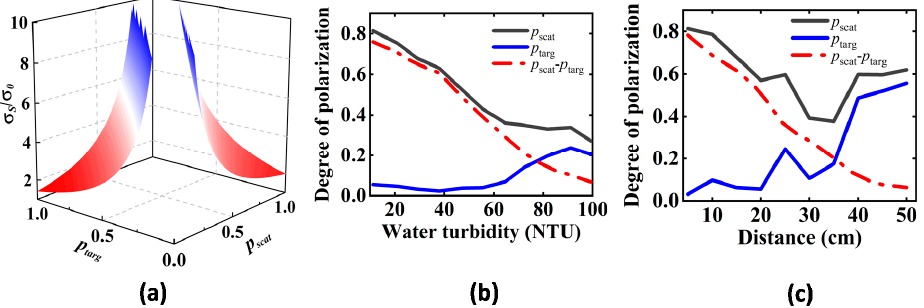
Figure 1. ( a ) Variation of noise amplification of target signal light with p scat and p targ ; ( b ) variation trend of p scat , p targ , and ∆ p with increasing turbidity of the water; ( c ) variation trend of p scat , p targ , and ∆ p with increasing imaging distance in the water with turbidity of 34.0 NTU.